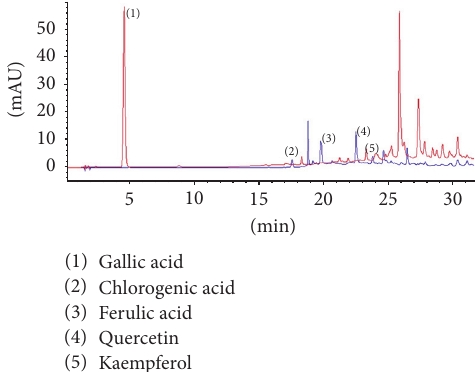
Figure 1: Chromatograms of phenols in onion samples at 280 and 350 nm (red and blue lines,